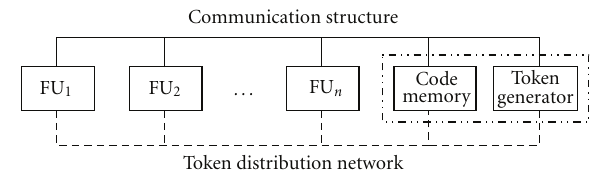
Figure 1: Abstract Model of an AMIDAR processor.